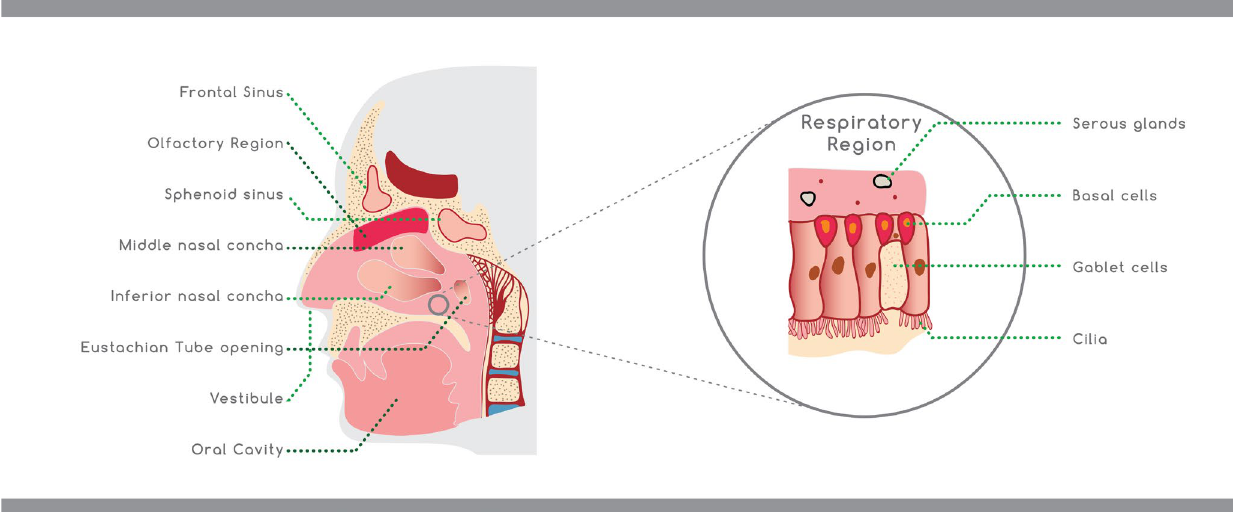
Figure 2. Schematic representation of the nasal cavity.